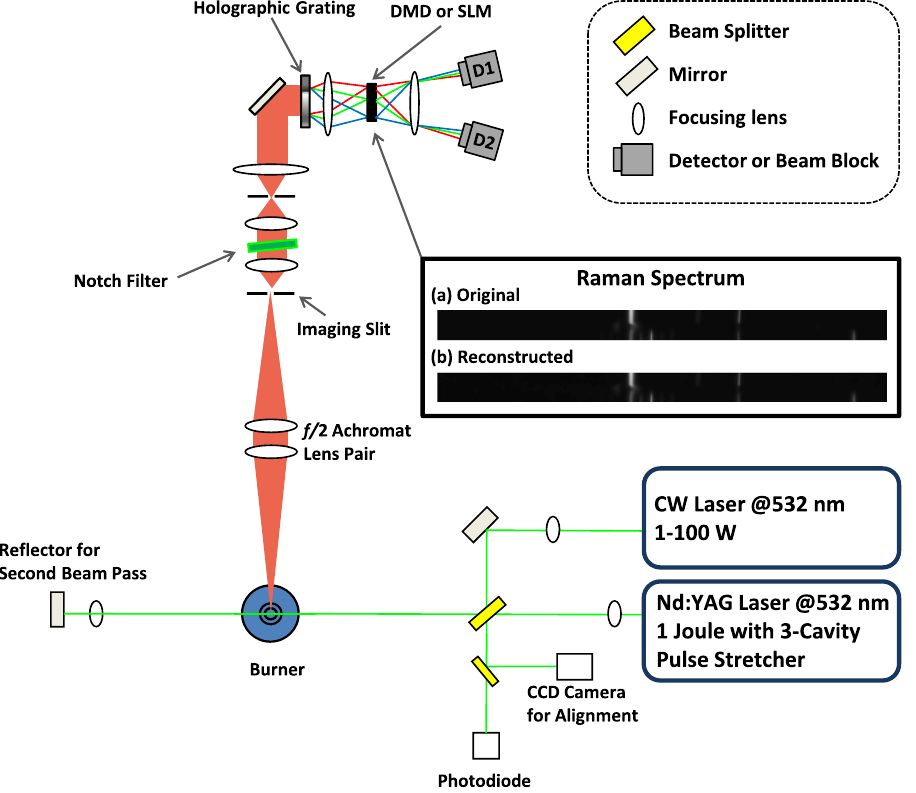
Figure 2. Experimental setup. Either a pulsed Nd:YAG laser or a high power CW diode laser is double-passed through the sample flame. Inelastically scattered Raman light is collected via a lens pair and directed toward a very narrow imaging slit and then through a transmission spectrometer composed of a holographic notch filter, imaging lenses and a holographic grating. The output from the spectrometer passes through a DMD or SLM and the resulting light is directed to two APD (or PMT) detectors with fast timing resolution and high quantum efficiency. Alternatively, one of the detectors can be replaced by a light-dump to reduce cost and complexity. For the SLM, polarization optics would be required to separate the two paths. The inset shows the ( a ) original and ( b ) reconstructed Raman spectrum measured 5.5 mm from the nozzle. The 512 × 32-pixel image has been scaled for clarity and shows the long axis as the spectrum and the short axis as the radial